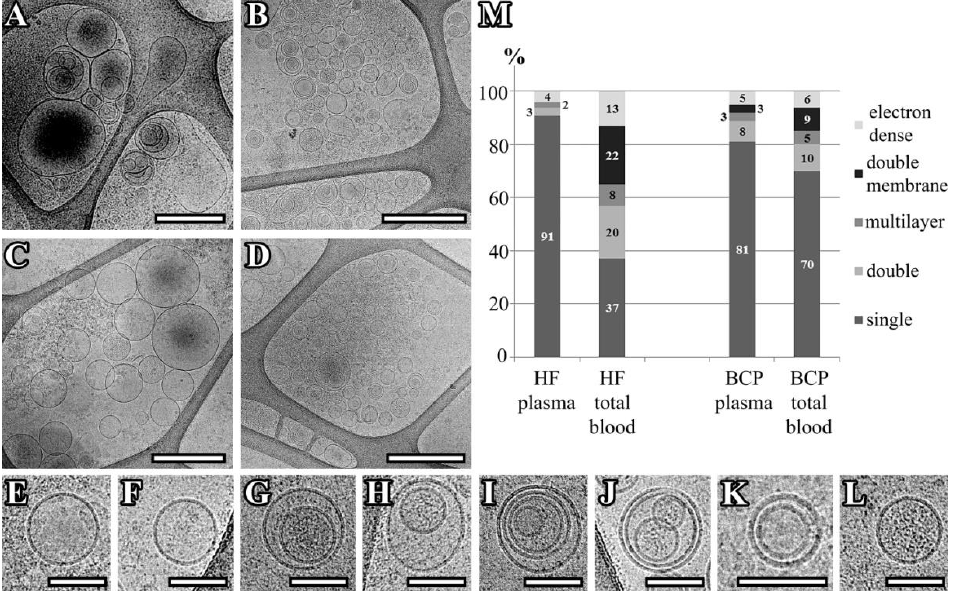
Figure 1. Representation of exosomes with various morphologies. A–L: Cryo-EM images of exosomes isolated from pooled samples of the plasma of HFs ( A ), Total blood of HFs ( B ), plasma of BCPs ( C ), total blood of BCPs ( D ), a single vesicle ( E , F ), double vesicles ( G , H ), multilayer vesicles ( I , J ), double-membrane vesicle ( I – K ), vesicles with an electron-dense cargo in lumen ( G , L ). Scale bars are 500 nm for micrographs ( A – D ) and 100 nm for micrographs ( E – L ). M : Percentages of single, double, double-membrane, multilayer, and vesicles with an electron-dense cargo visualized in the vesicle samples of pooled plasma and total blood from HFs and BCPs.